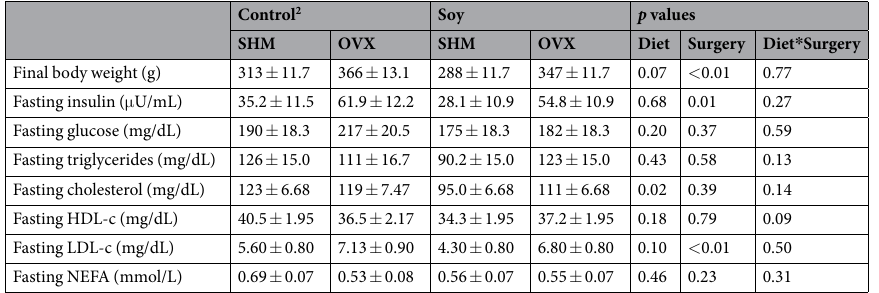
Table 2. Body weight and fasting blood parameters of ovariectomized (OVX) vs. sham-operated (SHM) rats bred for low-running capacity fed either a soy-rich (Soy) or soy-free diet (Control). Values are least-squared means ± SEM, n = 8–10/group. Means in a row without a common superscript letter differ, P <